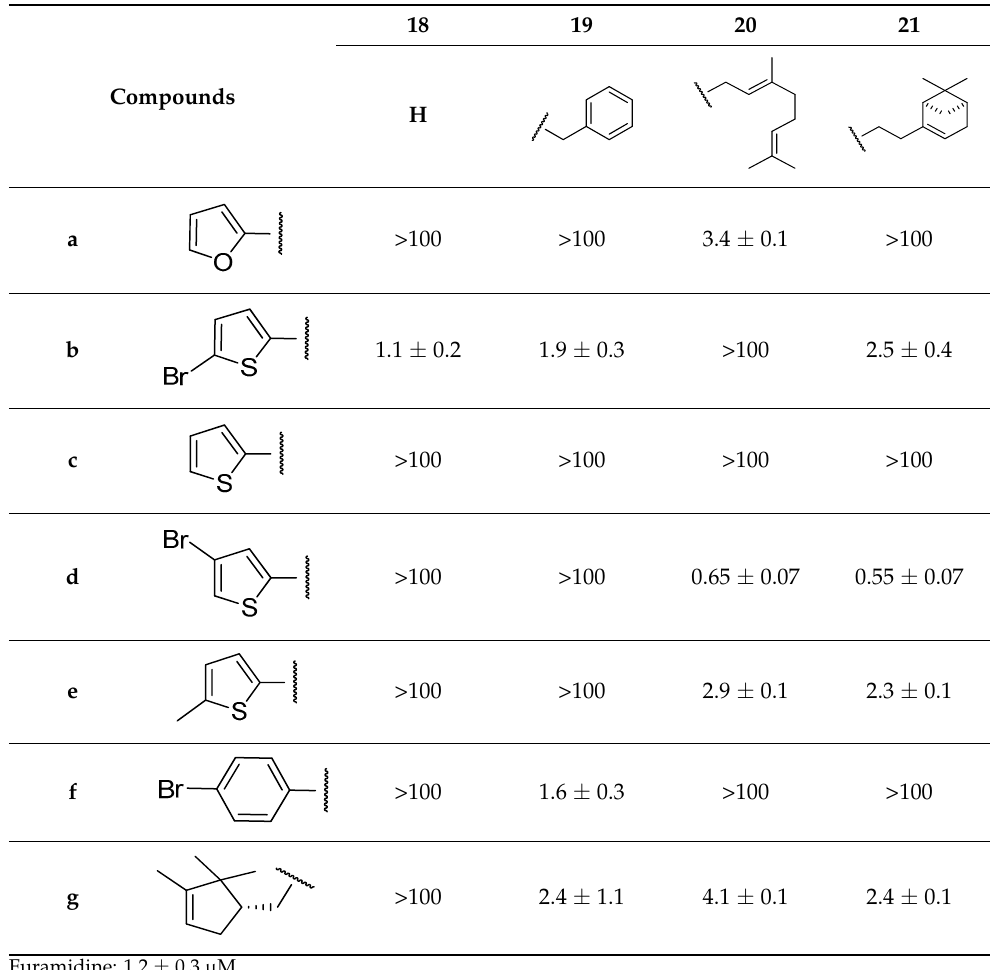
50 , μ M). Table 1. TDP1 inhibitory activities of the thiazolidine-2,4-dione derivatives (IC 50 , μ M).